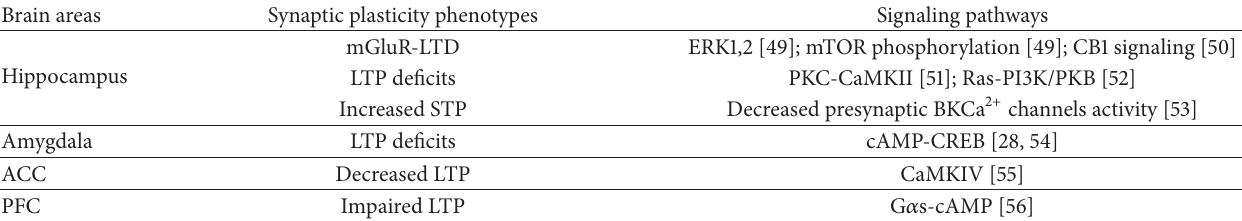
Table 2: FMRP selectively regulates signaling pathways associated with transcript targets in different brain